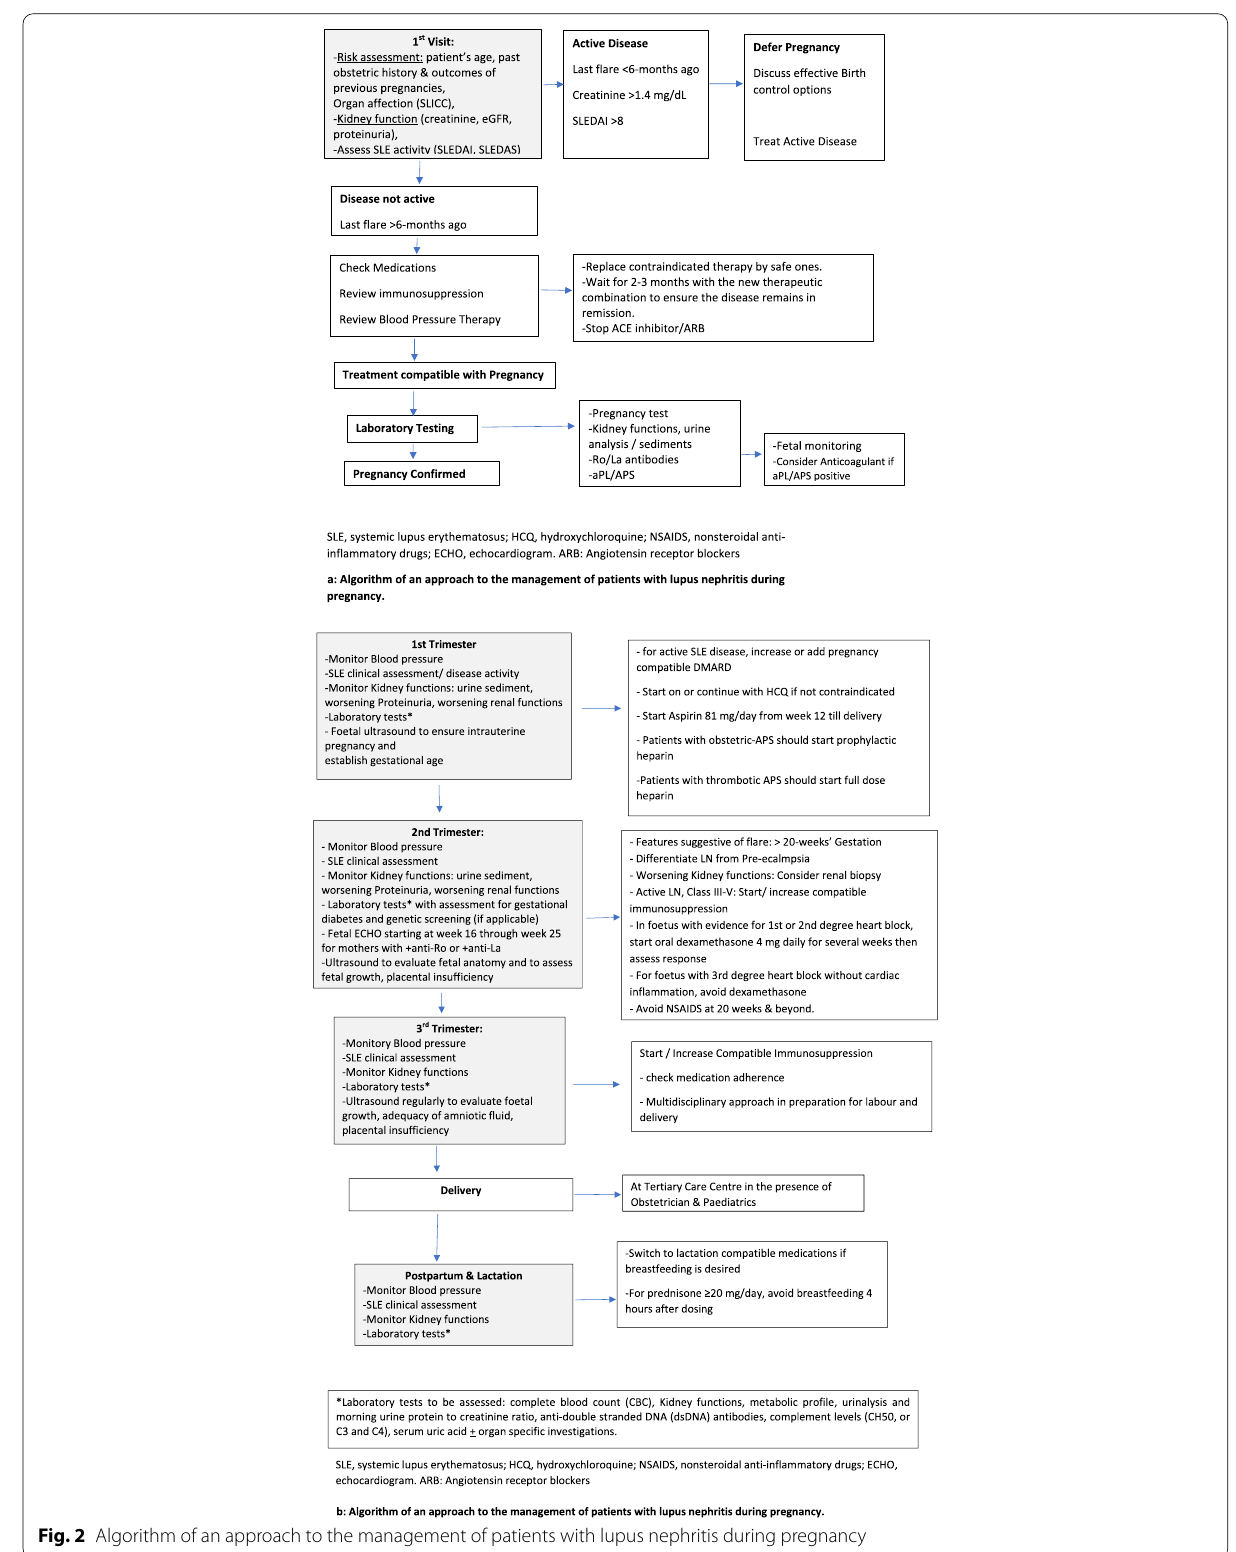
Fig. 2 Algorithm of an approach to the management of patients with lupus nephritis during